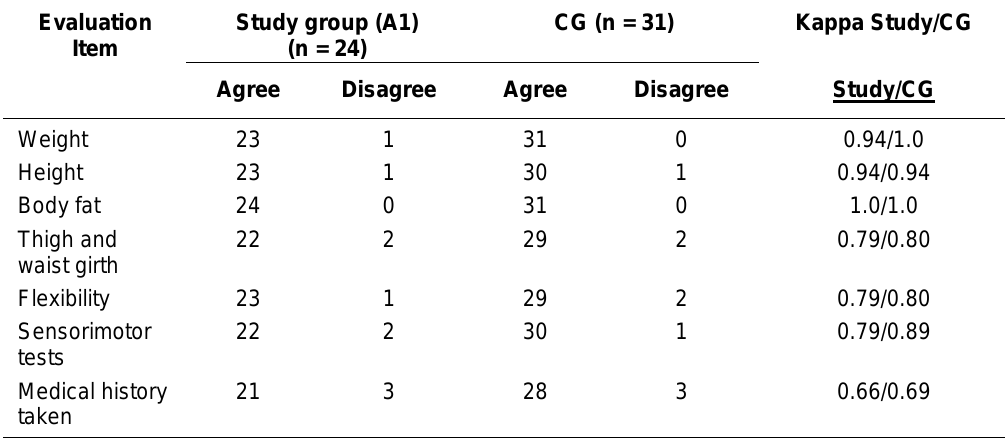
Inter-Rater Reliability Results for Evaluation Items for the Group of Older Persons with ID (A1, DS, and NSID) and